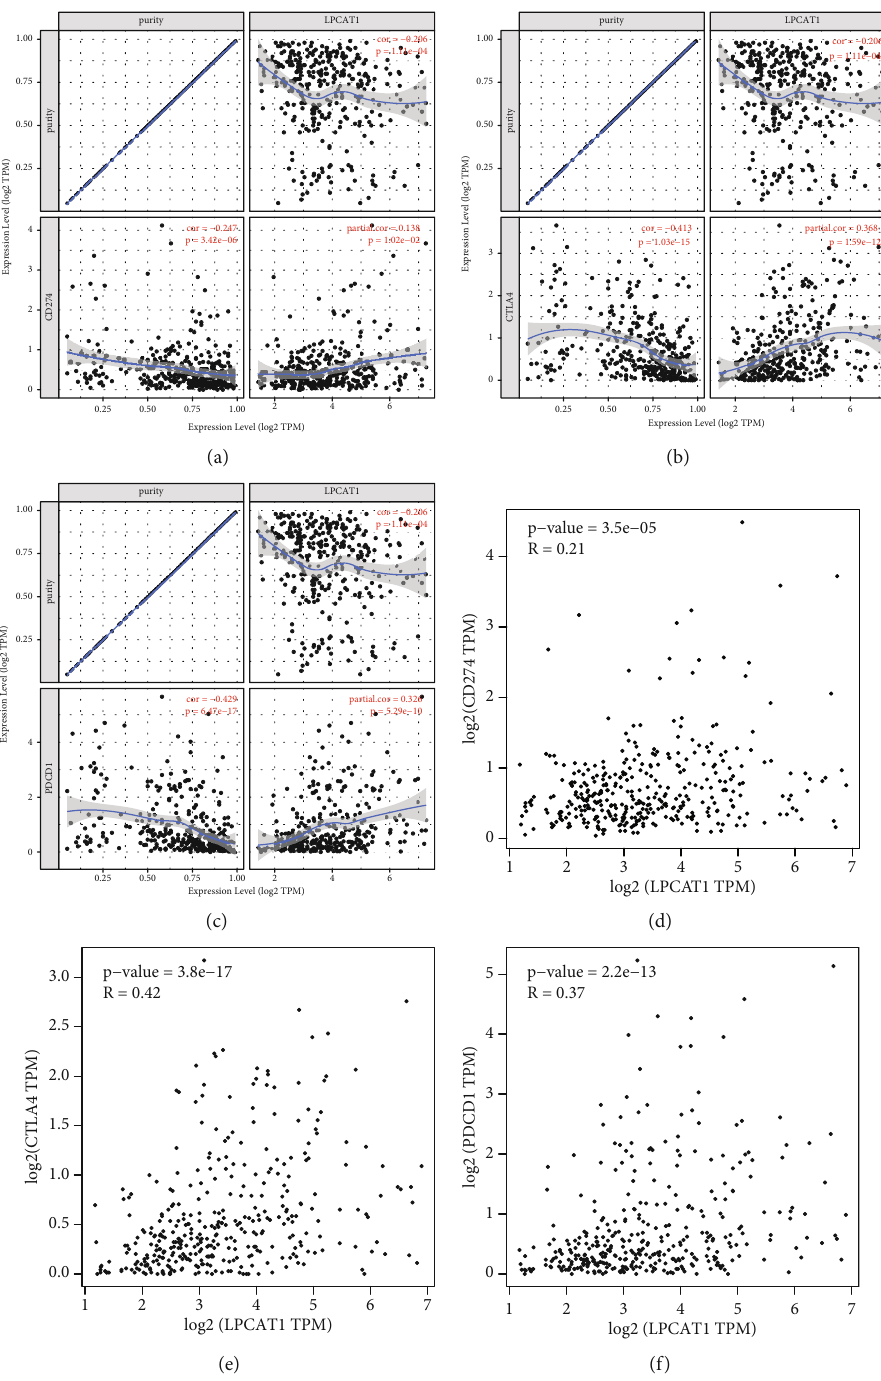
Figure 7: Correlation of the LPCAT1 expression with CD274, PDCD1, and CTLA-4 expression in LIHC. (a) Spearman correlation of LPCAT1 with the expression of CD274 in LIHC adjusted by purity using TIMER. (b) Spearman correlation of LPCAT1 with the expression of PDCD1 in LIHC adjusted by purity using TIMER. (c) Spearman correlation of LPCAT1 with the expression of CTLA-4 in LIHC adjusted by purity using TIMER. (d) The expression correlation of LPCAT1 with CD274 in LIHC determined by the GEPIA database. (e) The expression correlation of LPCAT1 with PDCD1 in LIHC determined by the GEPIA database. (f) The expression correlation of LPCAT1 with CTLA-4 in LIHC determined by the GEPIA